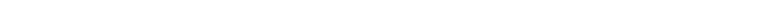
promotion of endothelial